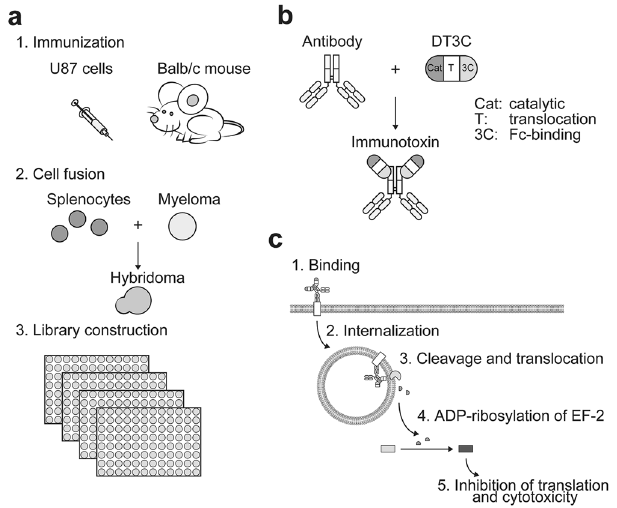
Figure 1. Screening pipeline. (a) Generation of anti-U87 hybridoma library. A hybridoma library was generated through: (1) immunization of BALB/c mice, (2) cell-fusion of splenocytes and myeloma cells, and